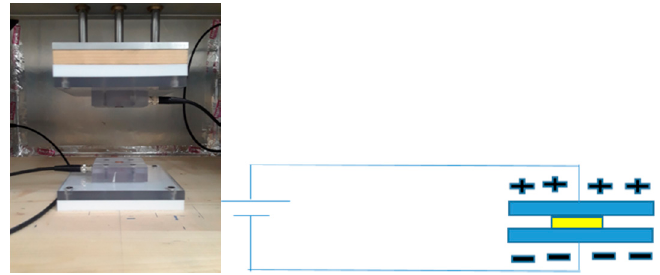
Figure 8. Test configuration and schematic representation of dielectric constant measurement.